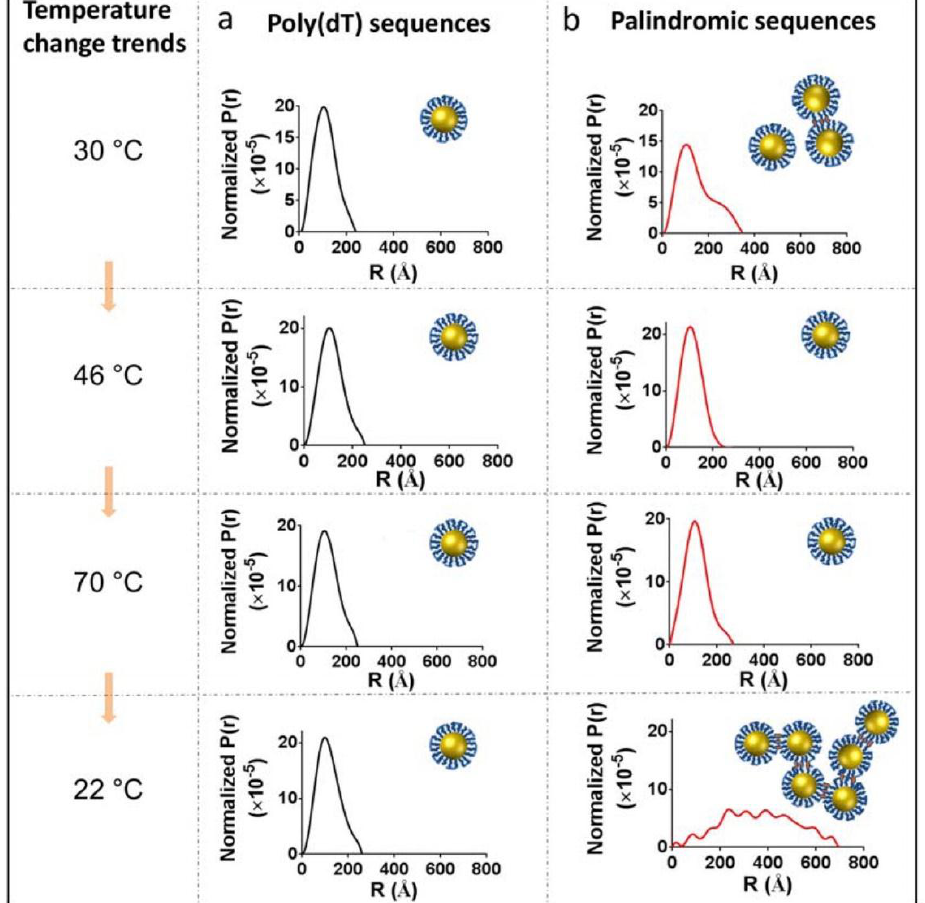
Figure 3. The pair distribution function P(r) is shown for two DNA-capped nanoparticles, T15 ( a ) and T7−8 ( b ) conjugates computed at various temperatures (30 °C, 46 °C, 70 °C, and 22 °C) in 0.5 M salt buffer. Insets are the scheme of temperature effect on poly(dT) sequenced deoxyribosenucleic acid (DNA) and palindromic sequenced DNA. Reprinted (adapted) with permission from (Yang, W.; et al. Probing Soft Corona Structures of DNA-Capped Nanoparticles by Small Angle Neutron Scattering. J.